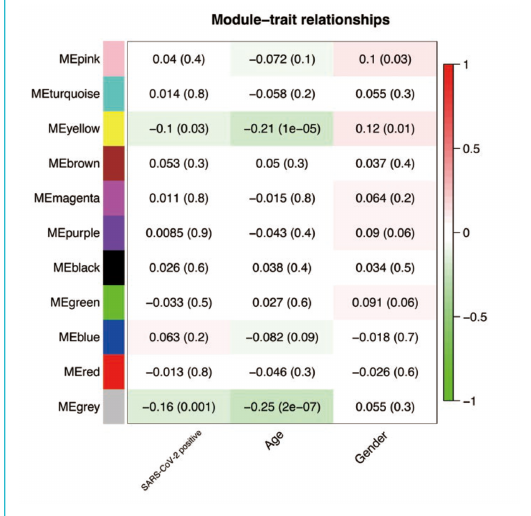
Figure 3: Relationships between gene co-expression modules and different clinical